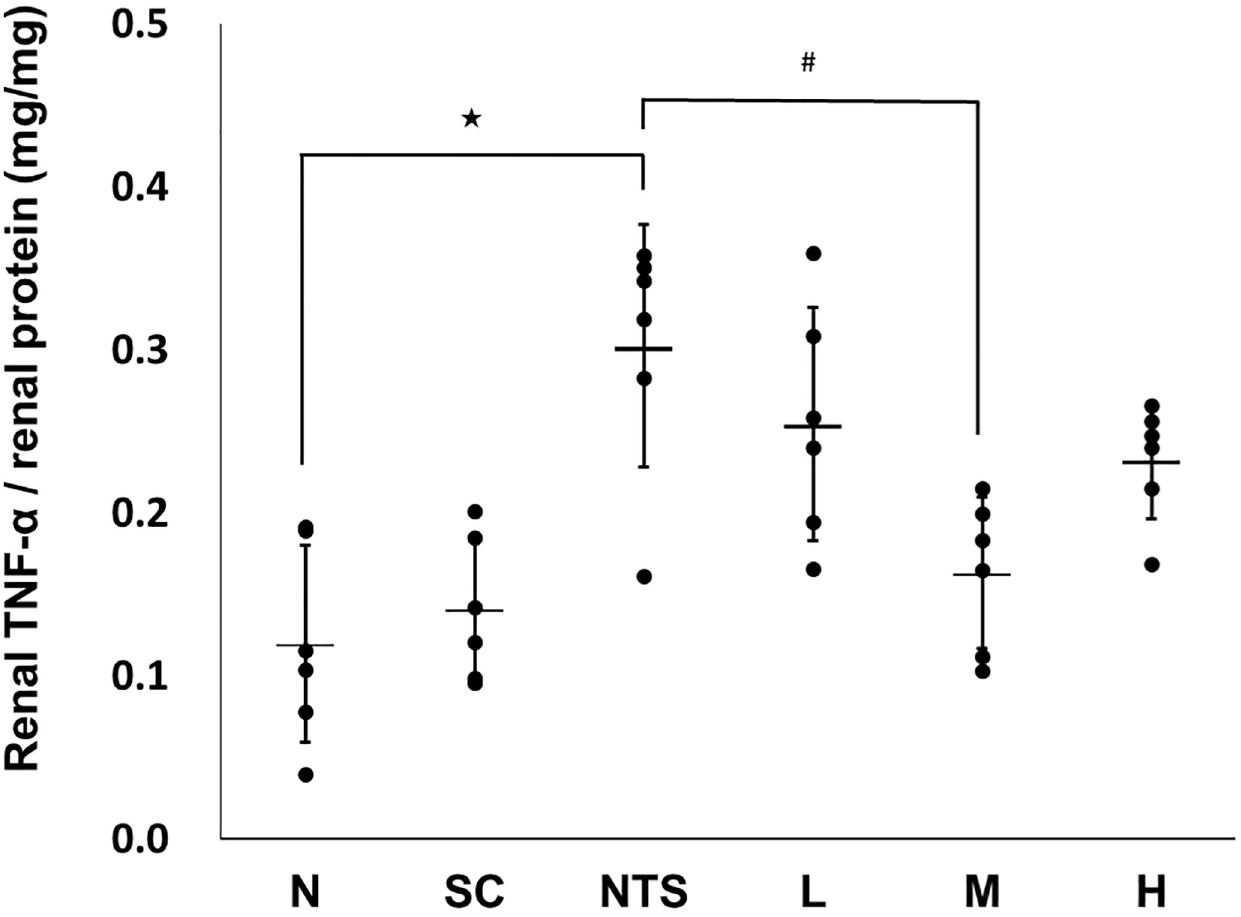
Fig 7. Renal TNF- α levels in the different experimental groups. N: normal group, SC: saikosaponin C control group, NTS: nephrotoxic serum control group, L: SSC 5 mg/kg/day treatment group, M: SSC 10 mg/kg/day treatment group, H: SSC 20 mg/kg/day treatment group. $ p < 0.05 compared to normal group, # p < 0.05 compared to NTS control